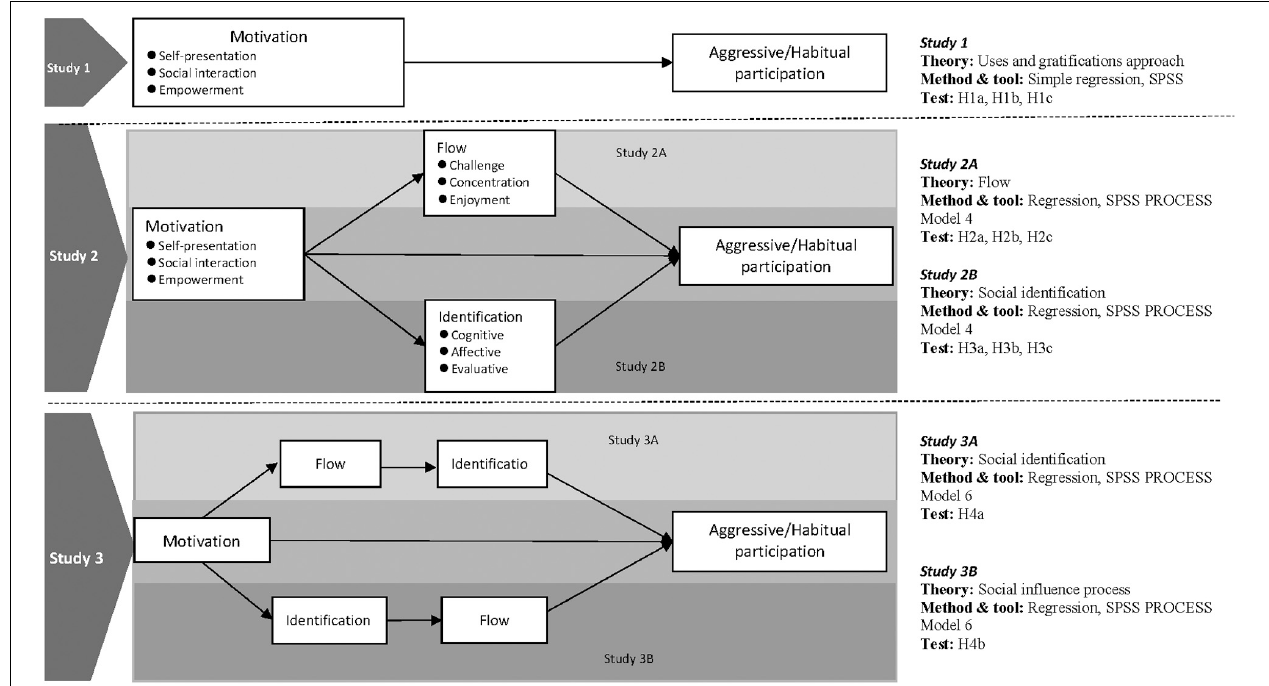
FIGURE 1 | Research overview and conceptual